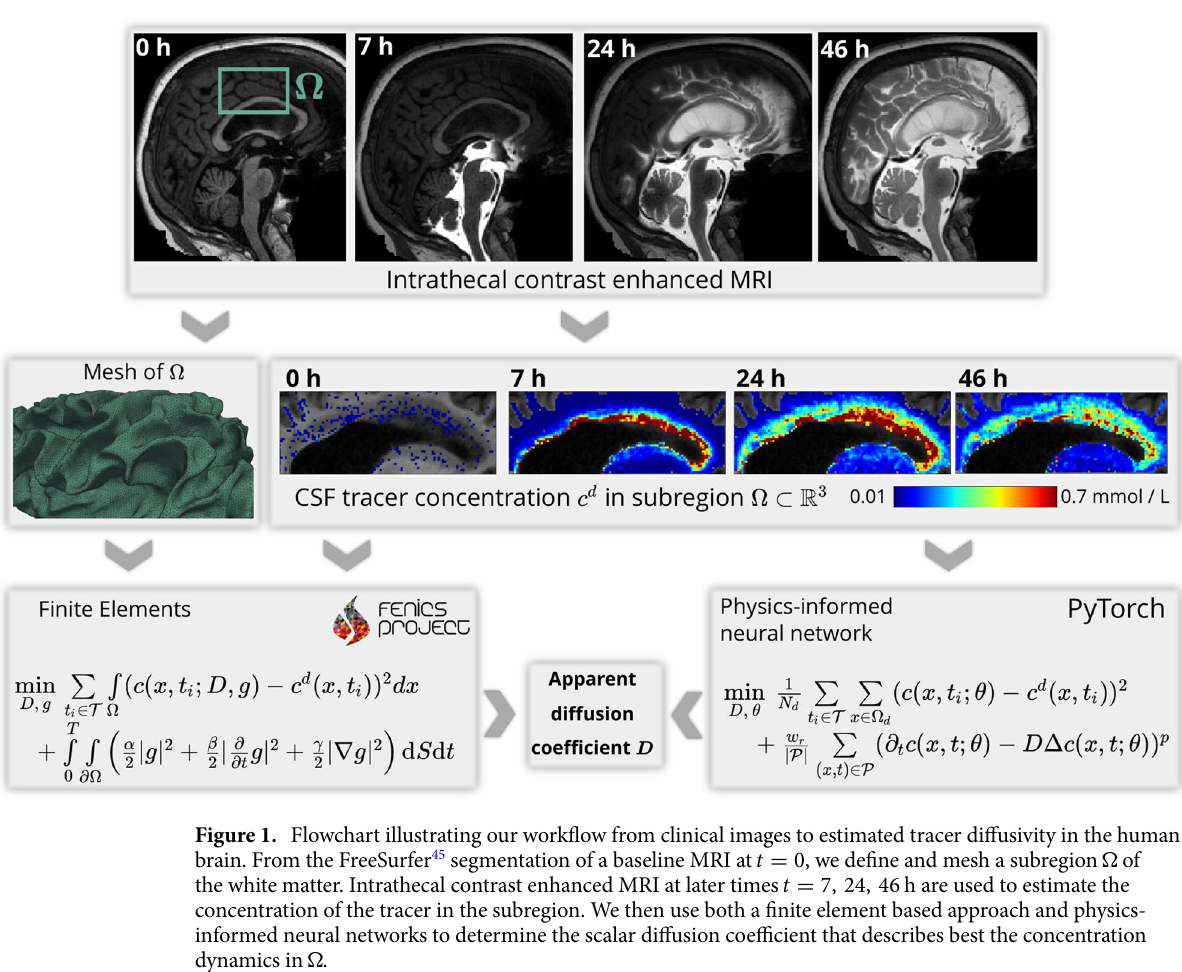
Figure 1. Flowchart illustrating our workflow from clinical images to estimated tracer diffusivity in the human brain. From the FreeSurfer 45 segmentation of a baseline MRI at t = 0 , we define and mesh a subregion (cid:31) of the white matter. Intrathecal contrast enhanced MRI at later times t = 7, 24, 46 h are used to estimate the concentration of the tracer in the subregion. We then use both a finite element based approach and physics- informed neural networks to determine the scalar diffusion coefficient that describes best the concentration dynamics in (cid:31) .